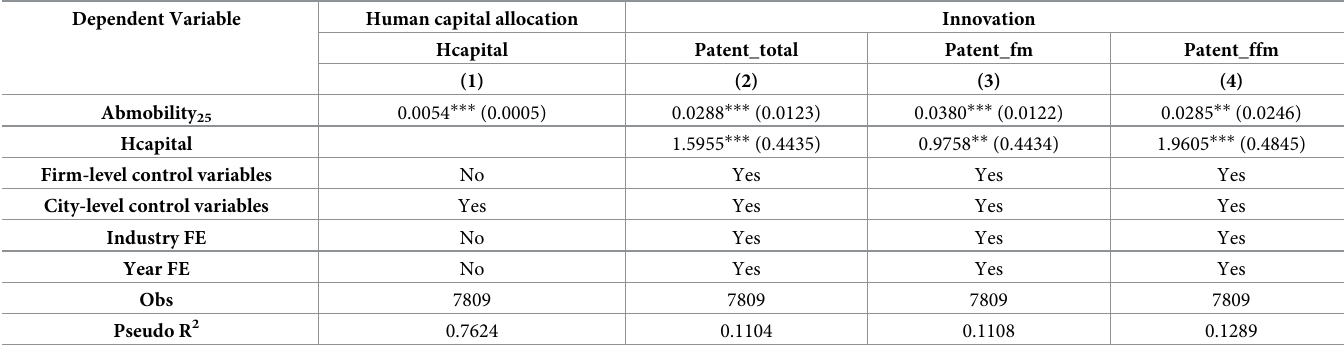
Table 3. Mediating effect tests: Human capital allocation.